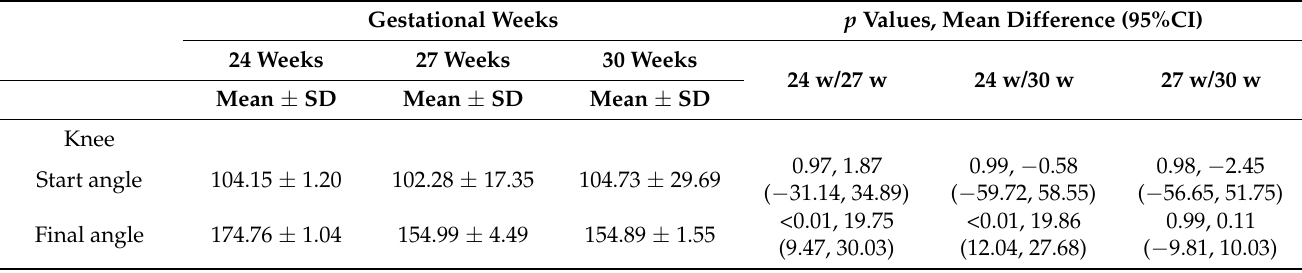
Figure 2. Lower limb joint angle changes during kicking motion at 24, 27, and 30 gestational weeks. Note: # indicates significant differences between 24 w and 27 w; % indicates significant differences between 24 w and 30 w. Table 1. Lower limb joint angle changes during kicking motion at 24, 27, and 30 gestational weeks (angle unit: